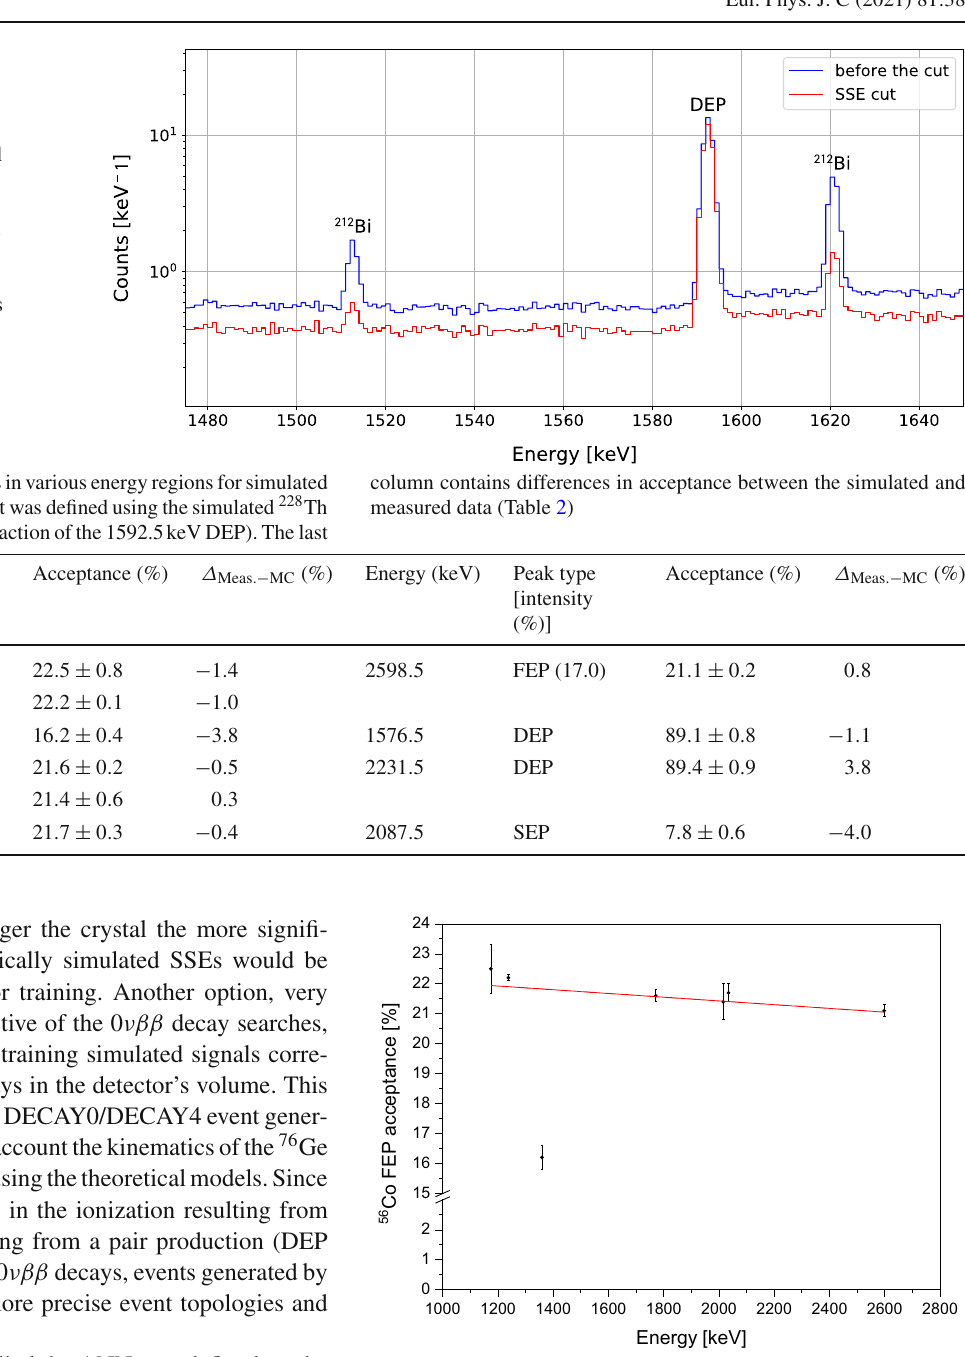
regions of the 228 Th spectra are collected in Table 5. The effect of the PSA cut on various peaks from 228 Th spectra is visualized in Figs. 22 and 23, for ANN trained on MC and measured pulses, respectively. From the data (Table 5) one can conclude that all con- sidered scenarios provide similar results with respect to the acceptances of the multi-site events (from FEPs and